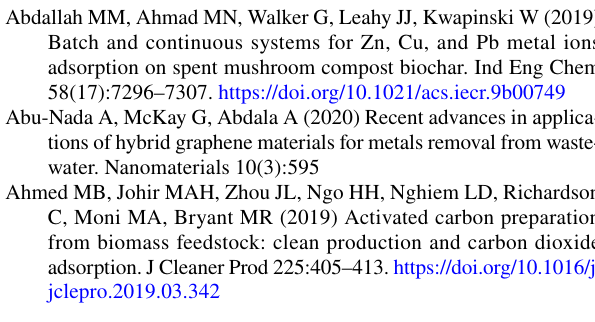
Fig. 12 Fitting curve for Pb(II) adsorption onto DES/H from real industrial wastewater(dosage = 0.2 g/L, [Pb] o = 81.0 mg/L, T = 30 °C, pH =